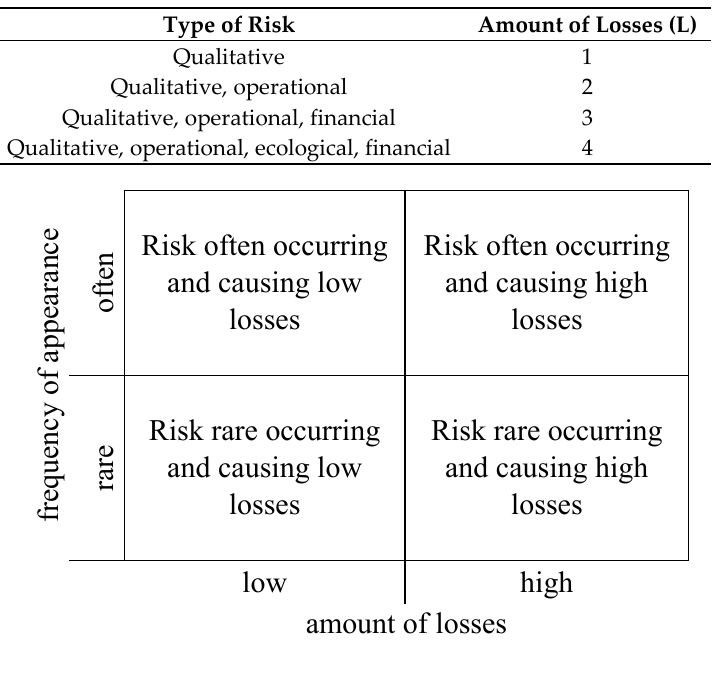
Figure 1. The simplest risk matrix—a risk map [6].